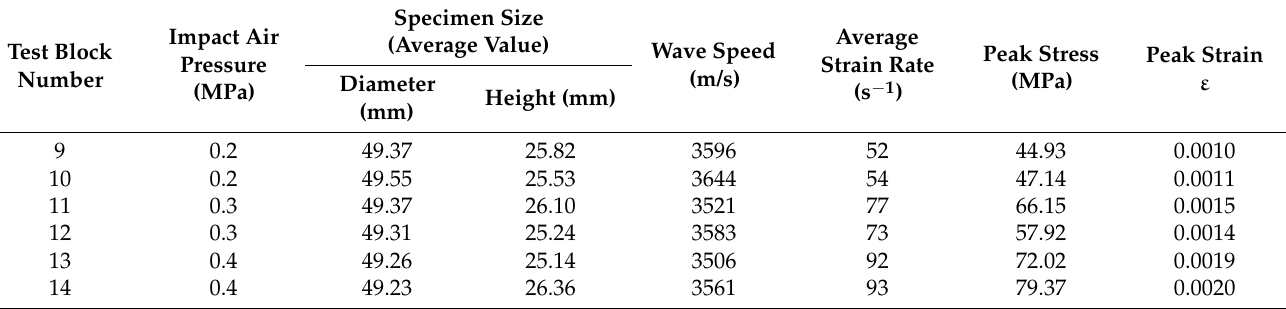
Table 4. Sandstone experimental